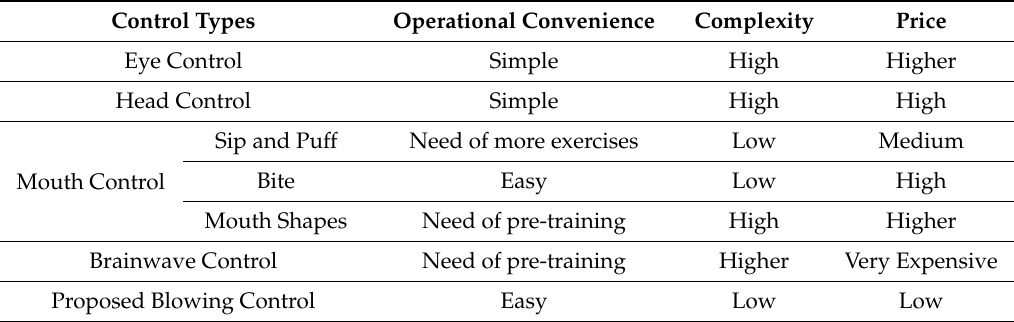
Table 5. Performance comparison of di ff erent mouse assistive